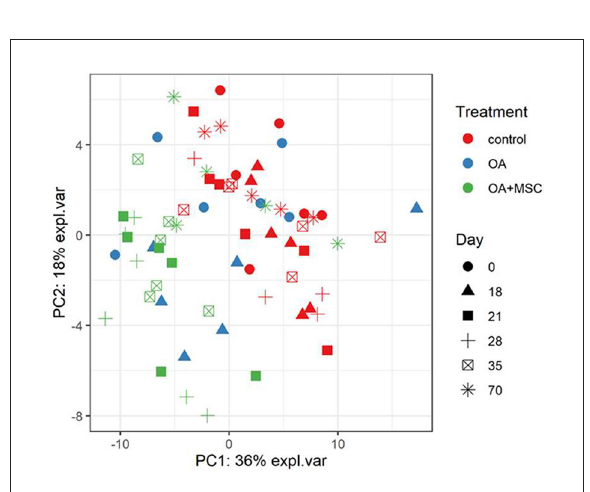
FIGURE5 Multi-level PCA (mPCA). The first two principal components are plotted, accounting for ∼ 54% of variance. Samples based on SWATH-MS. Each plotted point represents a horse, which are colored by their treatment and shaped by the day of the study.